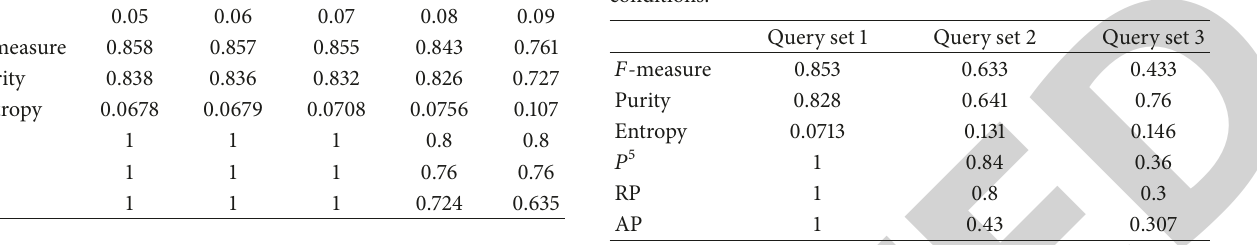
Table 9: The results of evaluation metrics on different 𝛽 ( 𝛼 = 0.05 ).